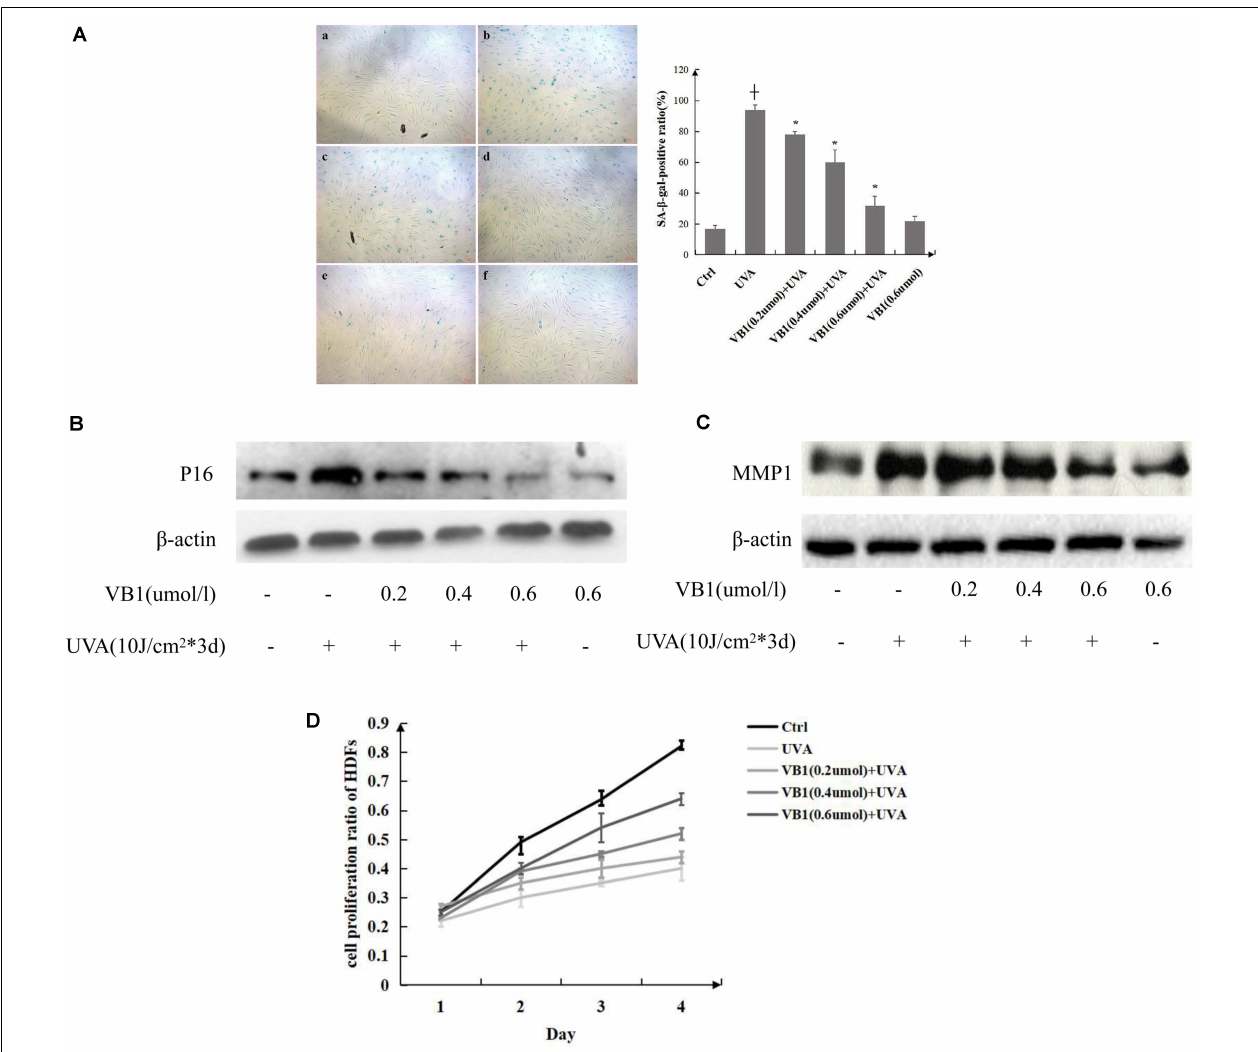
FIGURE 1 | VB1 protects HDFs from UVA-induced senescence. (A) HDFs senescence was evaluated by measuring the number of SA- β -gal-positive cells (left panel) [a, Ctrl; b, UVA; c, VB1 (0.2 µ mol/l) + UVA; d, VB1 (0.4 µ mol/l) + UVA; e, VB1 (0.6 µ mol/l) + UVA; f, VB1 (0.6 µ mol/l)]. Percentages of SA- β -gal-positive cells were determined by counting stained cells and total cells in four continuous visual fields under a microscope (200x). The SA- β -gal-positive rate was obviously enhanced in UVA-induced HDFs, while VB1 inhibited UVA-induced SA- β -gal activity in a dose-dependent manner. The analysis data was shown in right panel. Data are presented as mean HDFs ± SD ( n = 3; + vs. ctrl, p < 0.05, * vs UVA, p < 0.05). (B) p16 levels were detected by western blot analysis. Cells were irradiated as described and harvested 24 h after the final UVA exposure. Blots were probed to detect p16, stripped, and then reprobed for β -actin. VB1 inhibited UVA-induced p16 expression in a dose-dependent manner. Images are representative of 3 independent experiments. (C) MMP1 levels were detected by western blot analysis. VB1 inhibited UVA-induced MMP1 expression in a dose-dependent manner. Images are representative of 3 independent experiments. (D) The HDFs growth rate was determined by performing MTT assays. The growth rate of UVA-exposed HDFs was significantly decreased compared with control HSFs, while VB1 could reverse the decrease ( n = 3 for each time